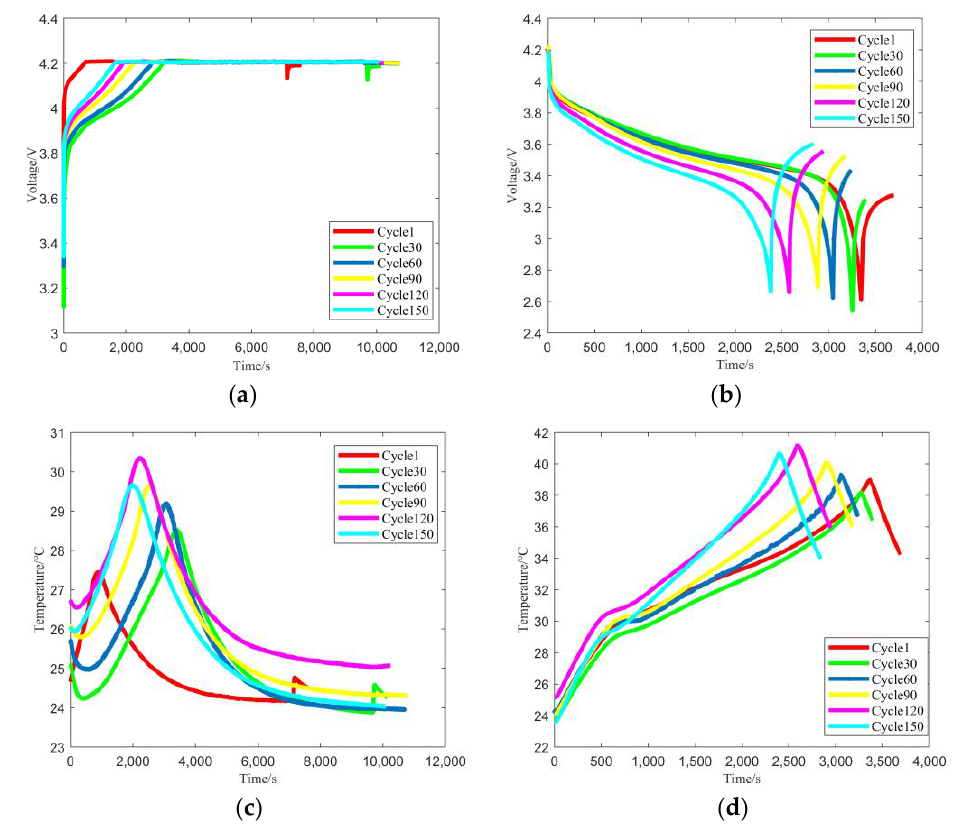
Figure 8. B0005 charge and discharge curves at different cycles. ( a ) Charge voltage curve; ( b ) Dis- charge voltage curve; ( c ) Charge temperature curve; ( d ) Discharge temperature curve.